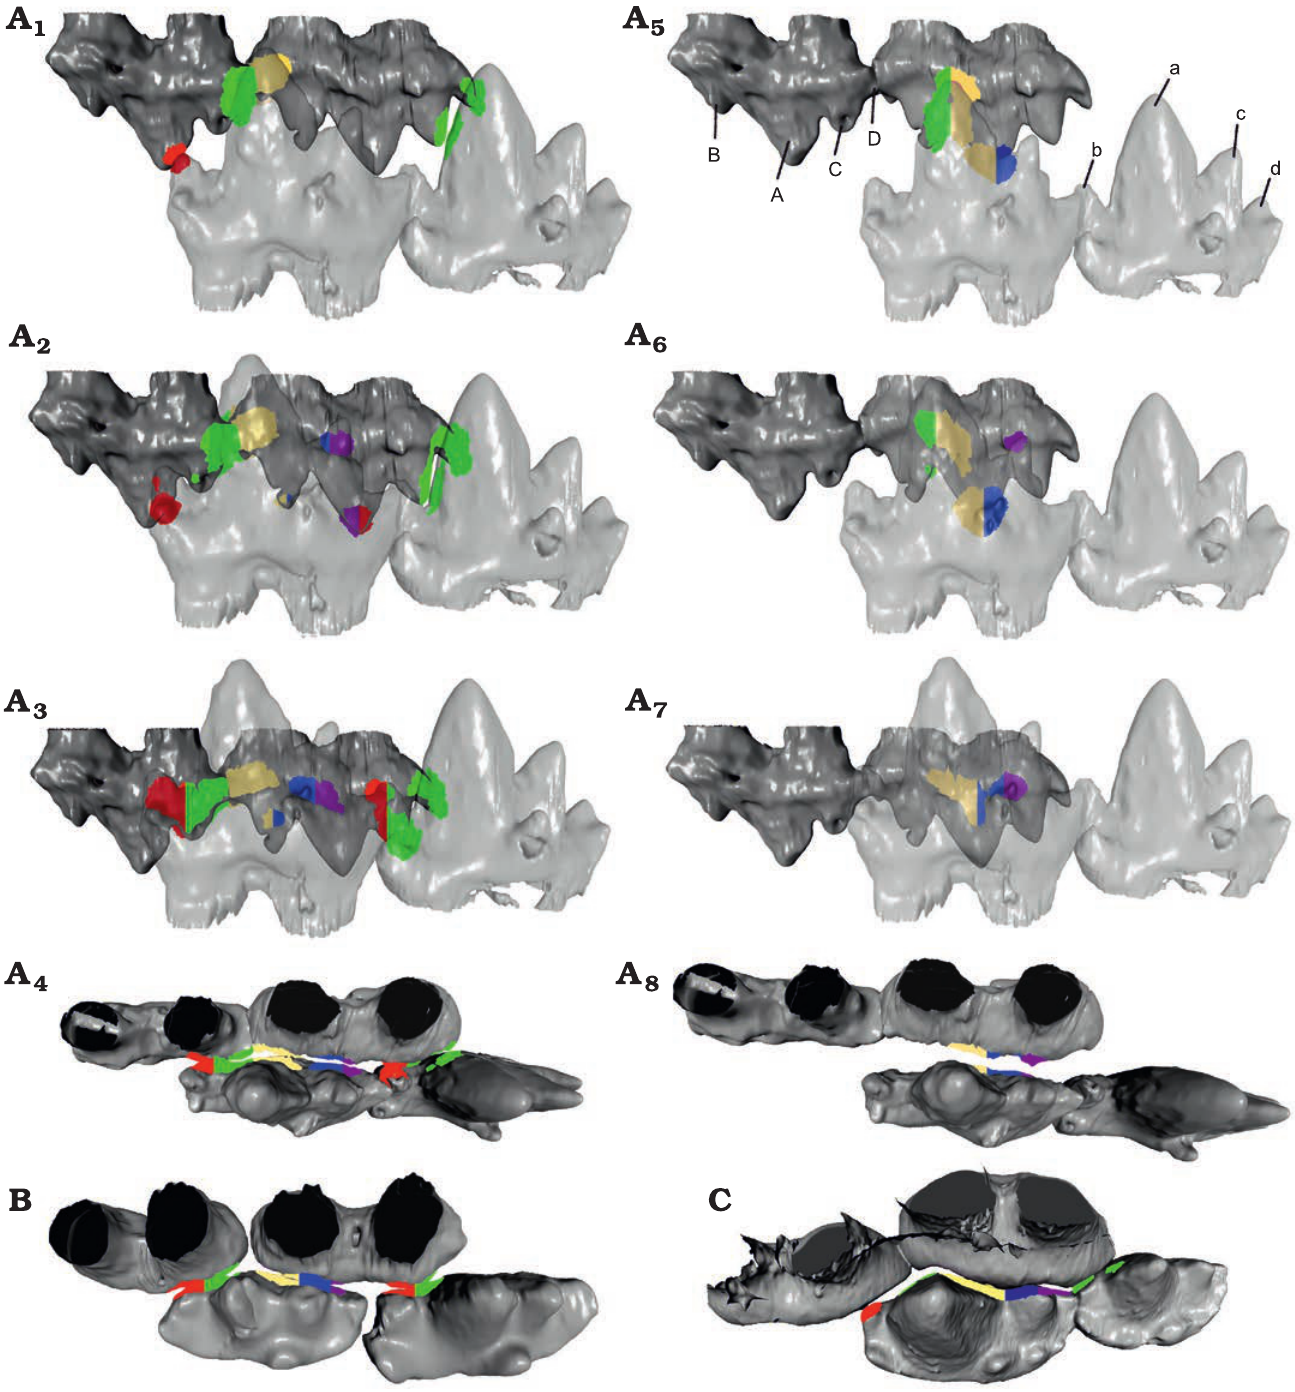
NHMUK PV M26407; Early Jurassic, Lesotho, Red Bed Series ( C ). Lingual view of Erythrotherium embrasure occlusion and Morganucodon -like occlusion, compared in early (A 1 , A 5 ), middle (A 2 , A 6 ), and late (A 3 , A 7 ) stages of the power stroke. Occlusal view of late stages of the power stroke of Erythrotherium with embrasure occlusion (A 4 ) with Morganucodon -like occlusion (A 8 ), Megazostrodon (B) and Morganucodon (C), note sufficient space between cusps a and c to accommodate cusp A. Additionally, the upper molars are angled to provide space for cusp a, especially the very large cusp a of m2. In comparison, the space between cusps a and c in Erythrotherium is much smaller and both lower and upper molars are aligned in a straight line, similar to Megazostrodon (A 4 , B). Therefore, Morganucodon -like occlusion in Erythrotherium lacks contact for the b/B and d/D cusps (A 8 ). Embrasure occlusion on the other hand results in collision detection on all major cusps and correlates with observed wear facets (A 4 ). This becomes most apparent in the later stages of the power stroke (A 3 ), where embrasure occlusion results in well-aligned teeth with the a/A cusps utilizing the space between two antagonists. With Morganucodon -like occlusion the direct contact of the a/A cusps prevents close contact of the smaller cusps (A 7 , A 8 ). Colored regions represent contact areas during the OFA analysis, for comparison see Jäger et al. (2019). Mesial is to the left. Not to